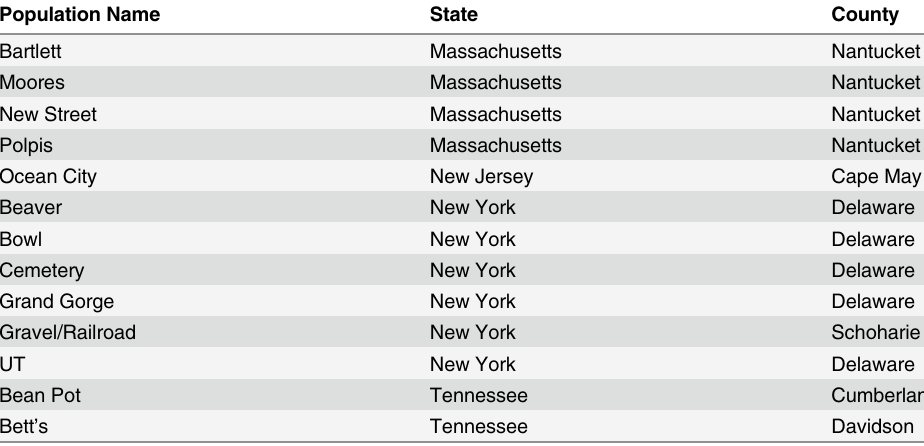
Table 1. Collection sites of wild carrot, Daucus carota ssp. carota ,